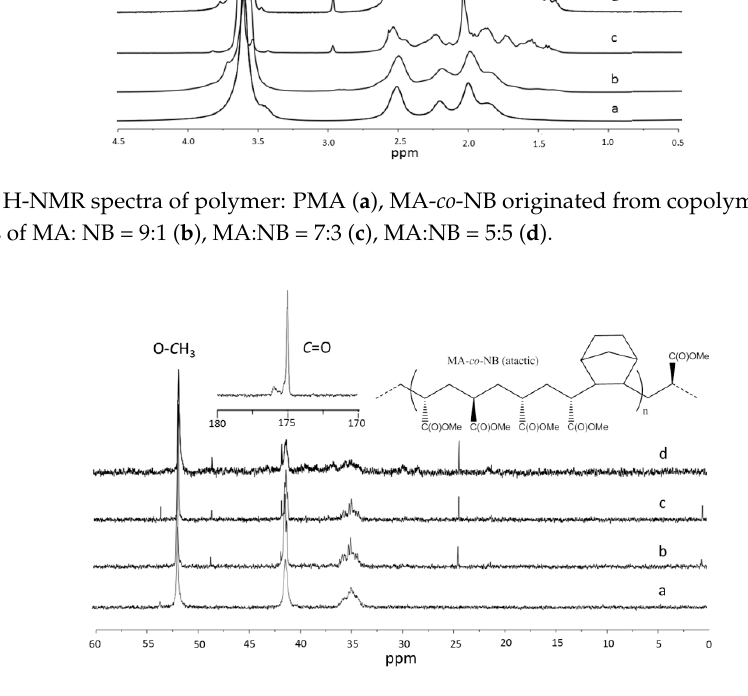
Figure 5. 13 C-NMR spectra of polymer: PMA ( a ), MA- co -NB originated from copolymerization with feed ratios of MA:NB = 9:1 ( b ), MA:NB = 7:3 ( c ), MA:NB = 5:5 ( d ).